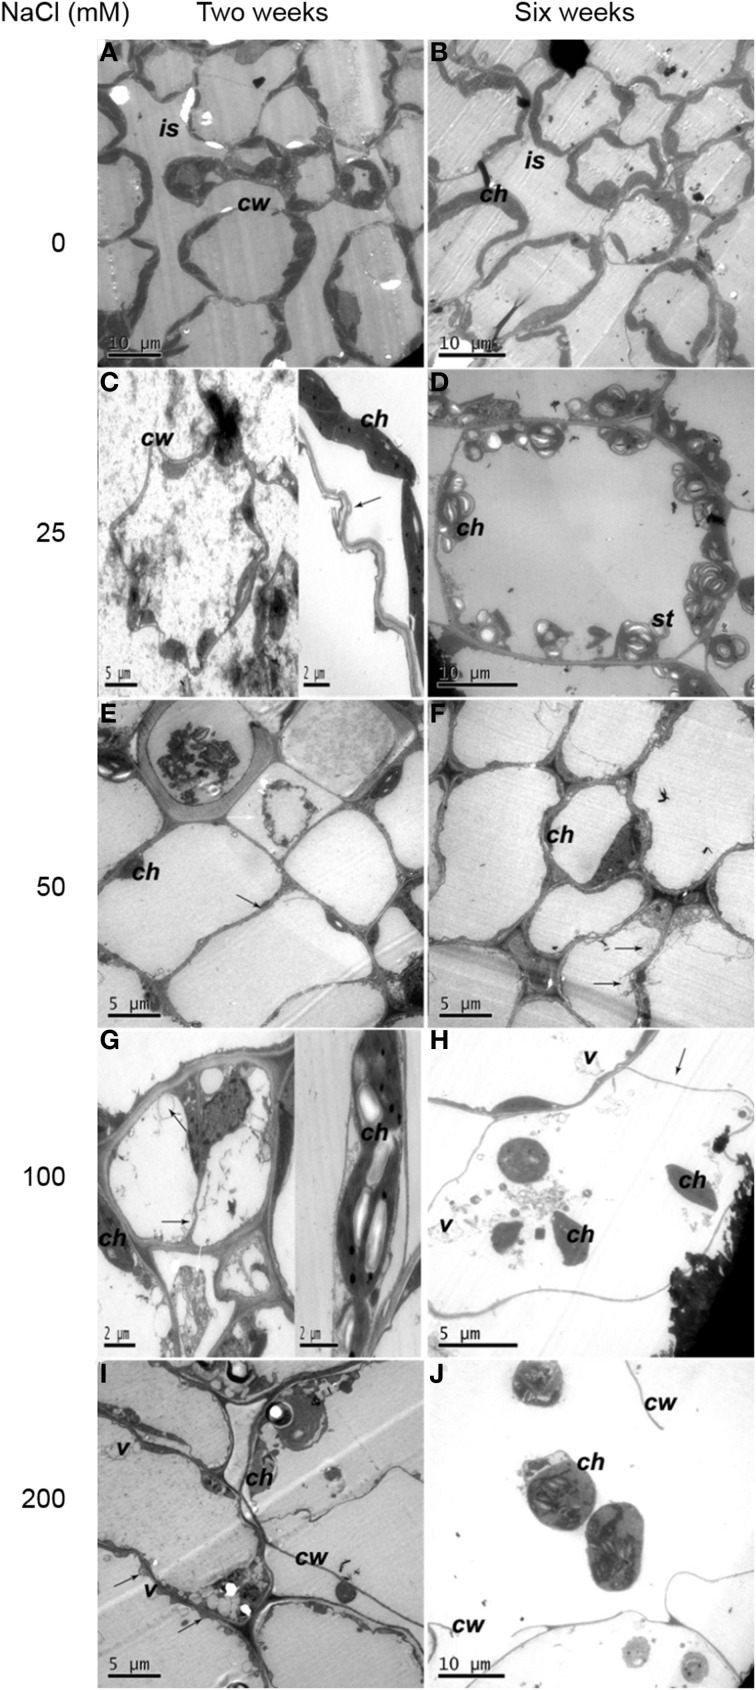
Ultrastructural changes of mesophyll cells. (A) Two weeks of non-salinity: intact mesophyll cells 2 weeks of non-salinity treatment. (B) Six weeks of non-salinity: more chloroplasts were present in mesophyll cells and cellular intercellular spaces increased for 6 weeks of 25 mM NaCl treatment. (C) Two weeks of 25 mM NaCl: cell walls were twisted, and the plasma membrane was apparently crimpled. Note chloroplasts were apart from the cell walls with membranous invaginations (black arrows). (D) Six weeks of 25 mM NaCl: mesophyll cell-contained chloroplasts have more starch grains. (E) Two weeks of 50 mM NaCl: mesophyll cells displayed plasmolysis (white arrow) and reduced intercellular spaces (black arrow). (F) Six weeks of 50 mM NaCl: complex vesiculation (black arrows), and dramatically reduced numbers of chloroplasts. (G) Two weeks of 100 mM NaCl: plasmolysis (white arrow), numerous vesicles (black arrows) and embedded chloroplasts. (H) Six weeks of 100 mM NaCl: cells showed severe plasmolysis (black arrows) and more vesicles and chloroplasts moved toward the cell center. (I) Two weeks of 200 mM NaCl: cells displayed severely damaged membrane systems, with severe membranous invagination (black arrow). (J) Six weeks of 200 mM NaCl: cell walls ruptured, and whole cells disintegrated. Note: ch, chloroplast; g, grana; pl, plastoglobuli; st, starch grains; w, cell wall; is, intercellular space; v, vesicle.